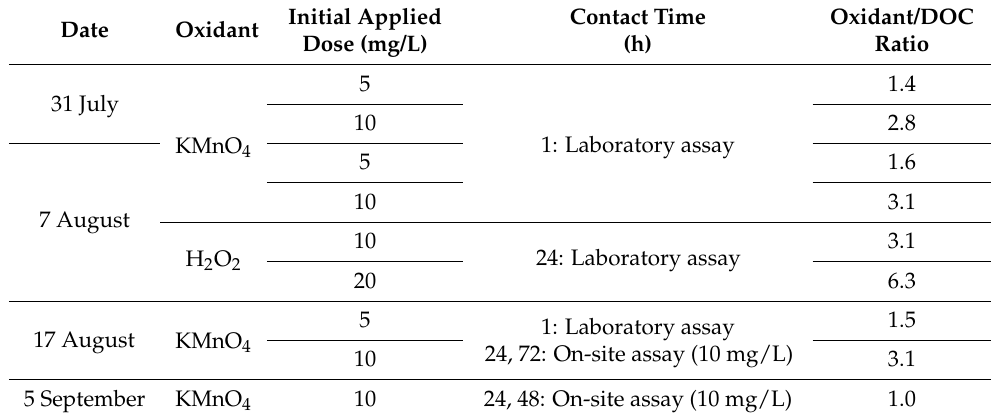
Table 1. Experimental plant of oxidation assays. DOC: Dissolved organic